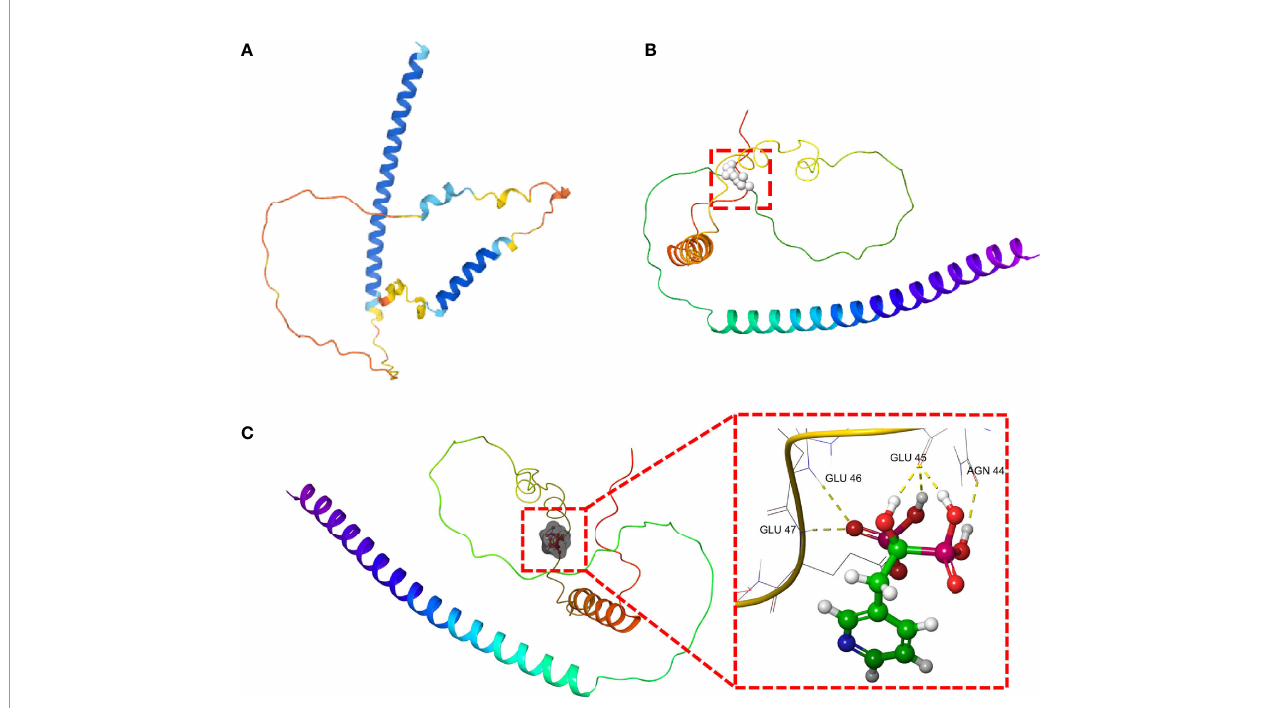
FIGURE 9 | The molecular docking of Risedronate with DDIT3. (A) The 3D structure of DDIT3 protein from AlphaFold. (B) The active site of the DDIT3 protein predicted by DoGSiteScore. (C) The docking result of Risedronate and